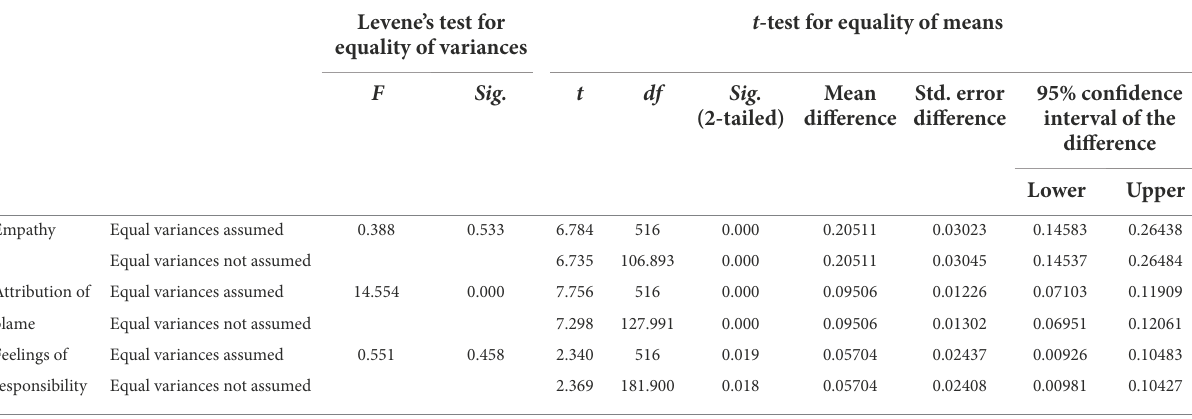
t -test for equality of